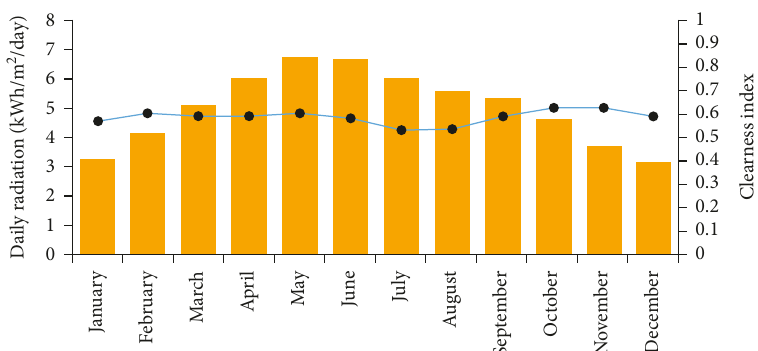
Figure 1: Solar energy potential at the selected location.